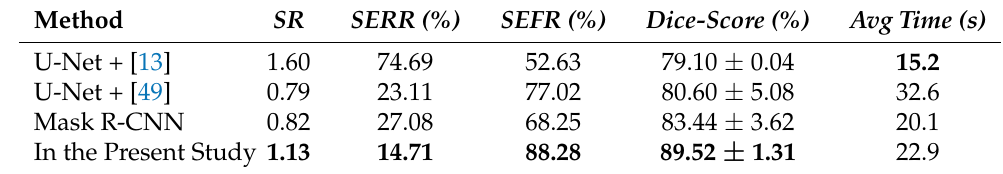
Table 1. The performance comparison of the proposed method with the other three overlapping object segmentation methods. The best results of micro-averaged SR , SERR , SEFR , and Dicescore (mean ± std) are